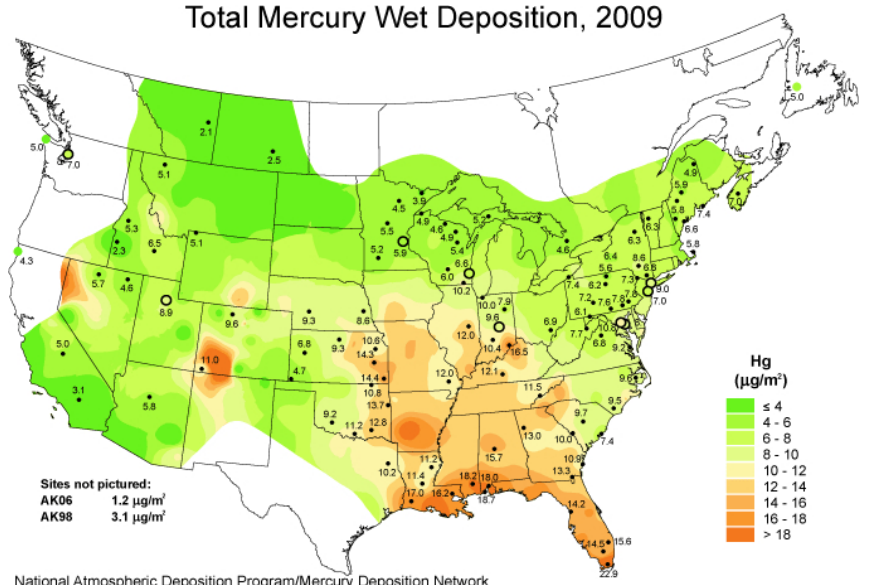
Fig. 1. Total mercury wet deposition for the year 2009. Note the regional maximum along the Gulf Coast. This is a consistent feature that is also present during other years (from National Atmospheric Deposition Program/Mercury Deposition Network,